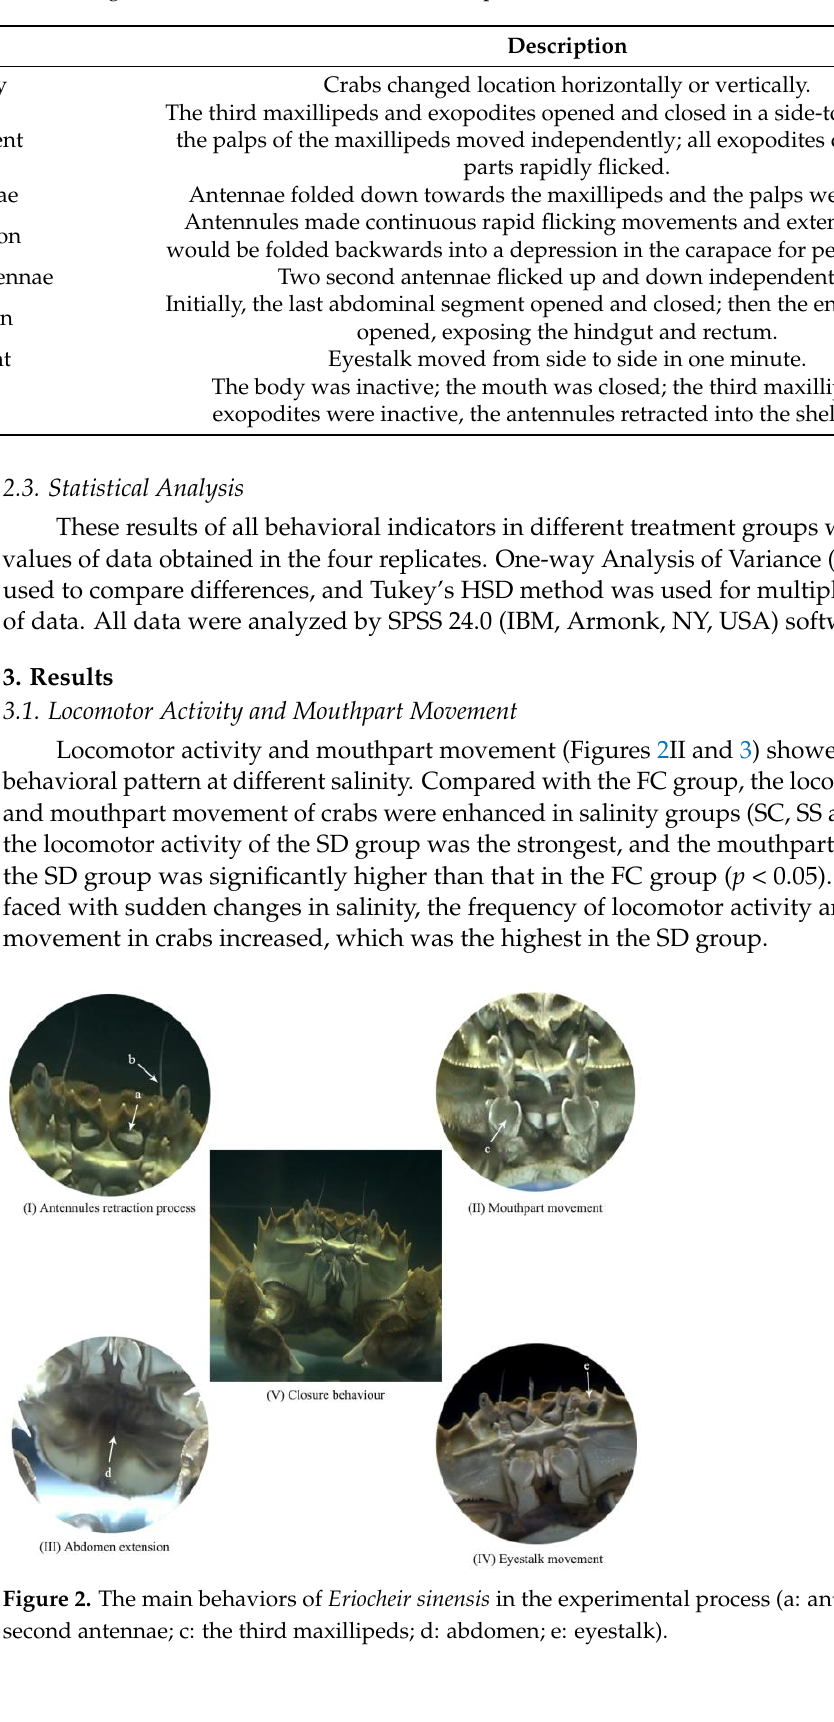
Table 1. Eight behavioral indicators observed in parent Eriocher sinensis .